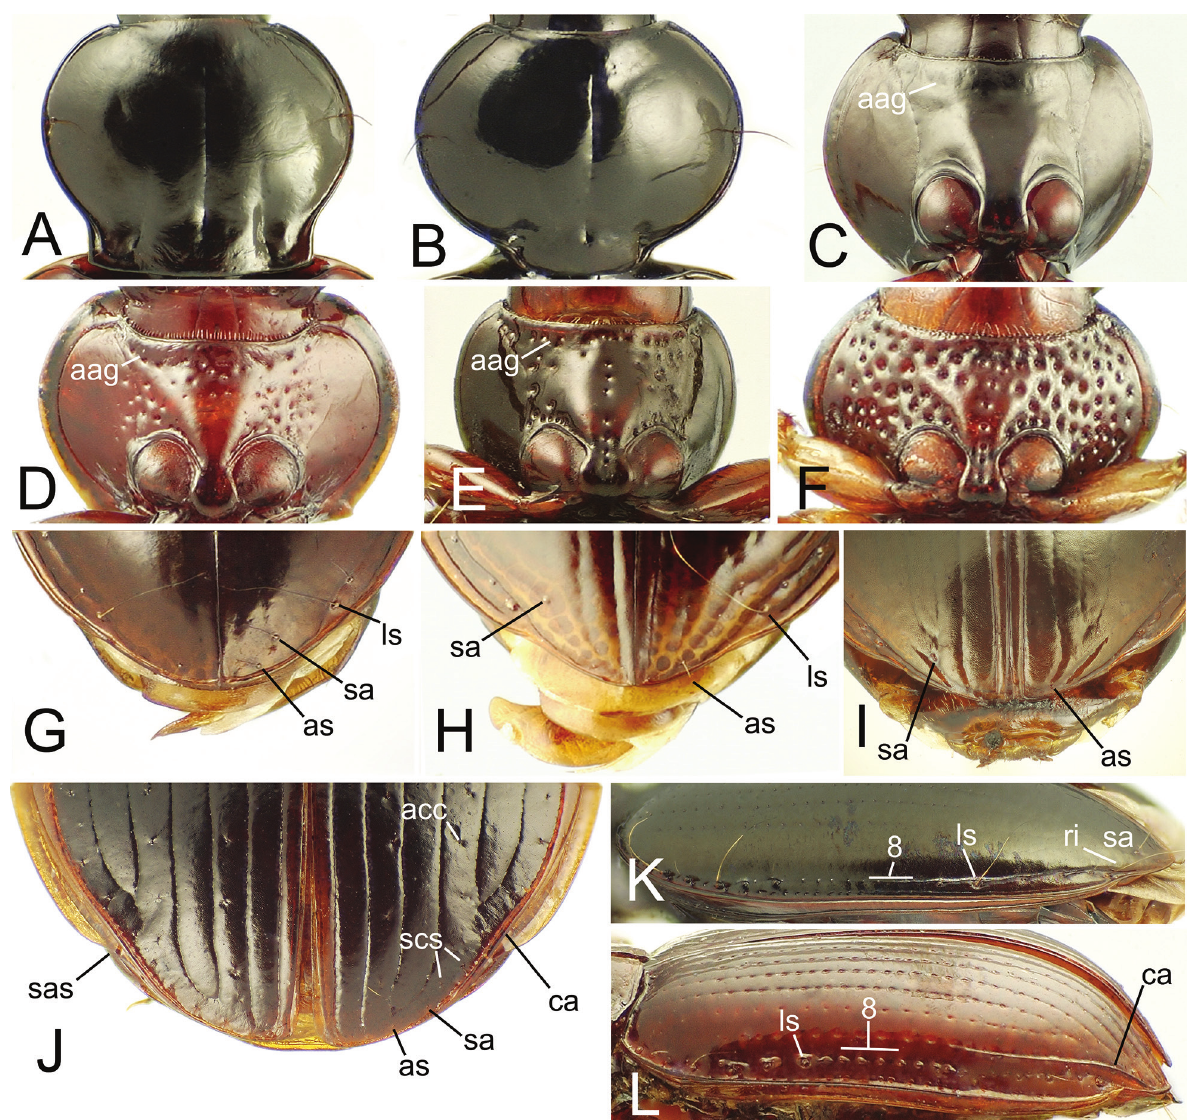
Figure 2. Thoracic structures of Mecyclothorax and Amblytelus spp. A–B . Pronotum, dorsal view: A , M. laterorectus ; B , M. mouen - sis . C–F . Prosternum, ventral view: C , M. fleutiauxi ; D , M. curtus ; E , M. blackburni ; F , M. moorei . G–J . Elytral apices, dorsal view: G , M. fleutiauxi ; H , M. laterorectus ; I , M. lissus ; J , A. curtus . K–L . Elytral lateral margin showing eighth stria, lateral view: K , M. ambiguus ; L , M. blackburni . Abbreviations include: aag , anteapical groove; acc , accessory elytral dorsal setae in interval 5; as , apical elytral seta; ca , carina laterad stria 7; ls , lateral elytral setae; ri , ridge mesad stria 8; sa , subapical elytral seta; sas , subapical sinuation of elytron; scs , supracarinal elytral setae; 8 , medial portion of stria